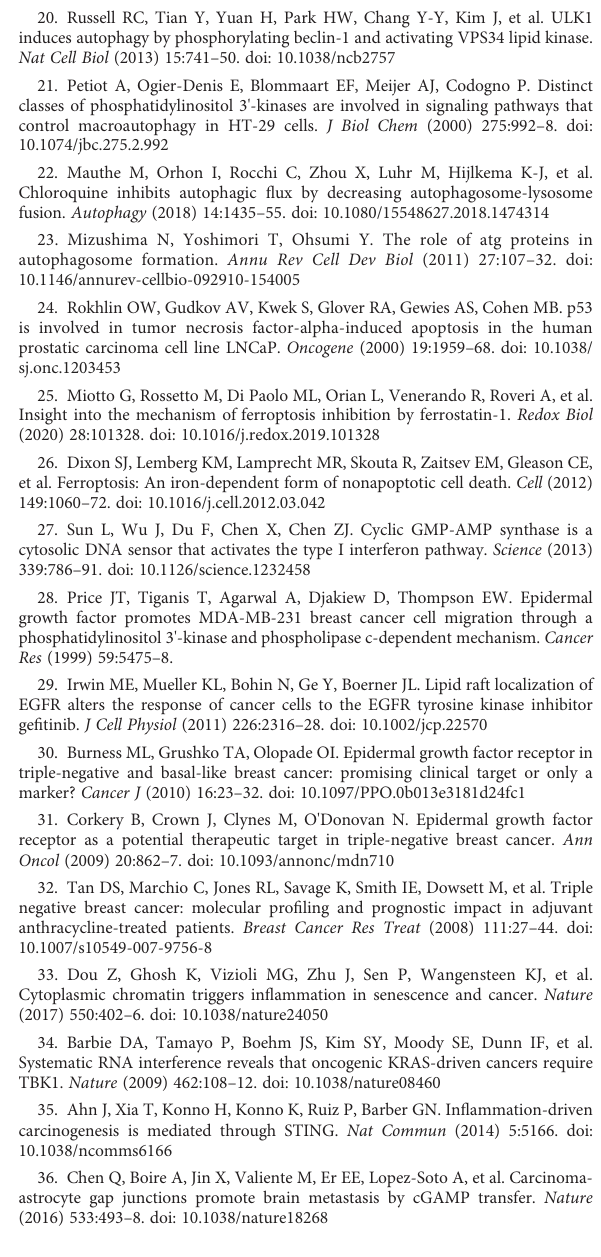
Supplementary Figure 7 The cGAS-STING pathway differentially modulates autophagic response in different culturing conditions. (A, C) , MDA-MB-231 (A) and SUM159 (C) cells were transiently transfected with cGAMP (10 m M)bylipofectamine 2000,followed bytreatedwithRU.521at 10 m M and 8 m M, respectively, in serum-replete media for 24 hr. For comparison, the cells of both cell lines were treated with RU.521 under serum-depleted media for 24 hr. Cells were then stained with acridine orange and red fl uorescence was captured by fl uorescence microscopy at a magni fi cation of 400x. Bar, 50 m m. The nuclei were counterstained by